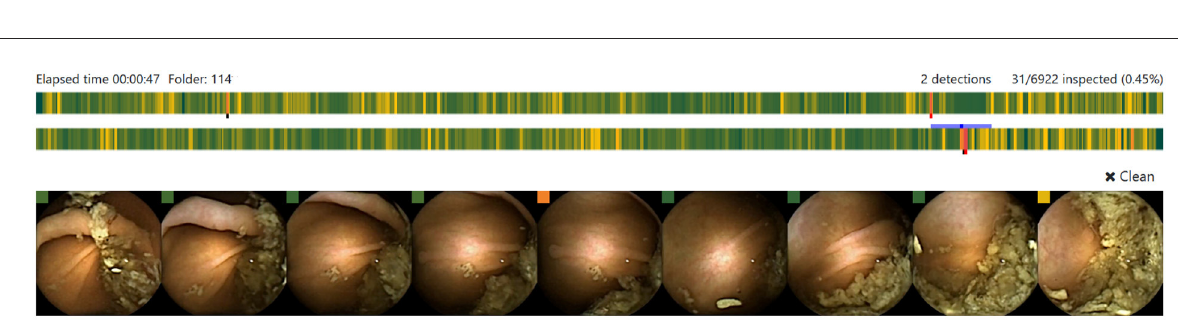
were fixed after a 5-Fold cross validation process using 120 CCE videos (2,080 polyp images and 246 k negative